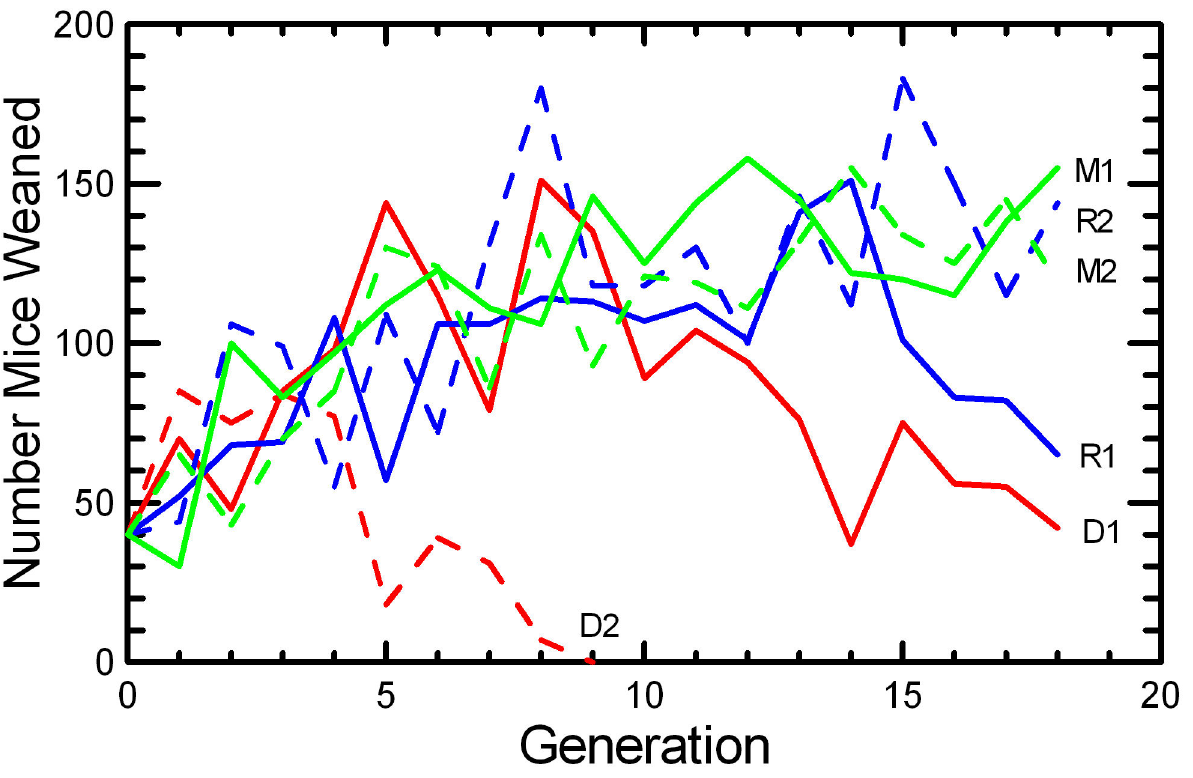
Figure 1. Size of experimental populations of Peromyscus leucopus mice across generations. Each population started with 40 mice in 20 pairs, and thereafter the population size is the number of mice weaned from up to 20 pairs established each generation. For all figures, the mean values at each generation for RAN replicates are shown in blue, MK replicates shown in green, and DOC replicates shown in red. Lines are labeled as to replicate to the right of each line. doi: